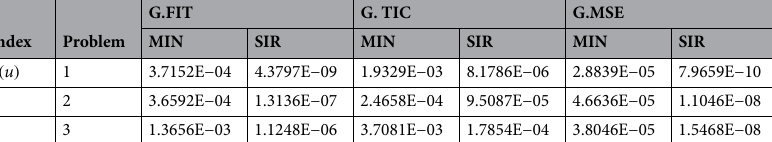
Table 4. Global representations by using the stochastic performances for solving the novel SO-PSDDM-based Problem 3.